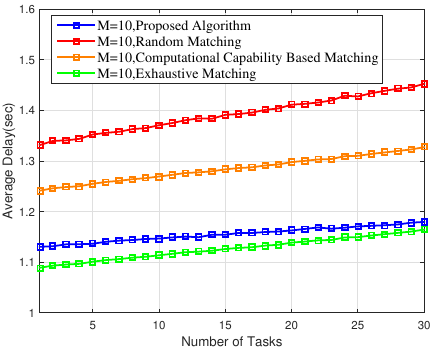
Figure 5. Average delay of the proposed scheme versus the random matching, CCBM, and exhaustive